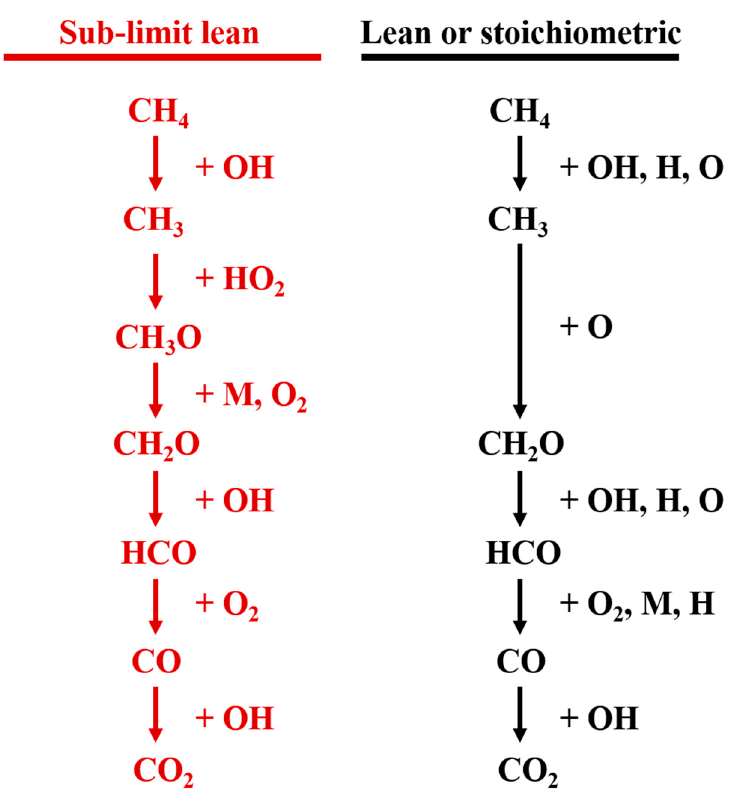
Figure14. Themajorreactionpathwaysofultra-leanmethanecombustionascomparedtoaconventional Figure 14. The major reaction pathways of ultra-lean methane combustion as compared to a methane conventional methane flame.